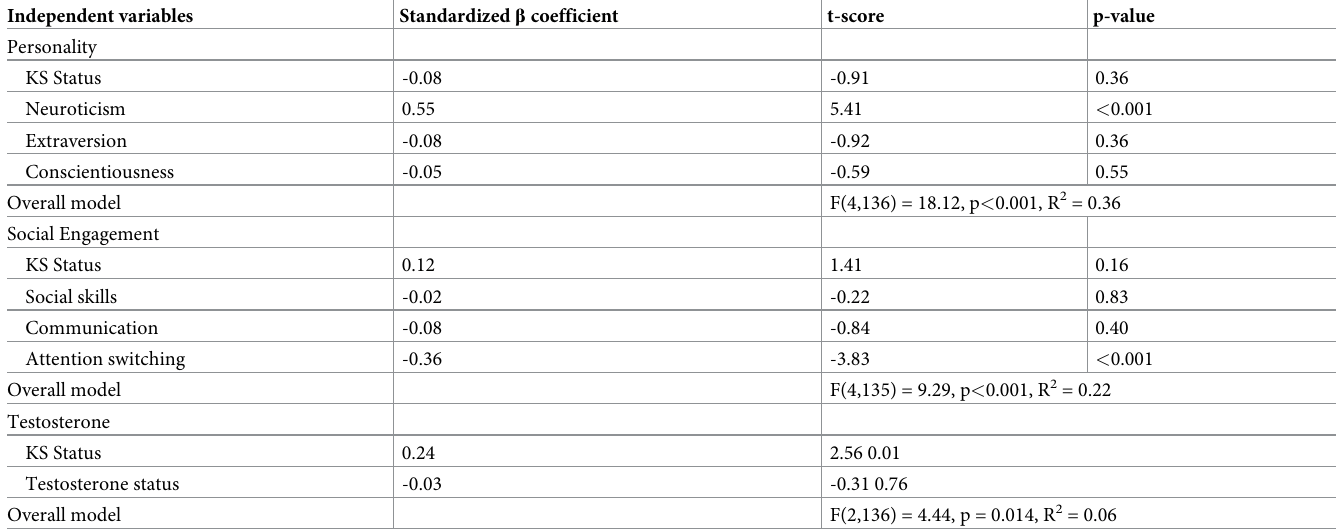
As shown in Table 4, KS status and personality measures (i.e., neuroticism, extraversion, and conscientiousness) combined to significantly predict depression symptoms (R 2 = .36, p < .001), with neuroticism emerging as the lone significant predictor (p < 0.001). Depression was also predicted by KS status and social engagement (i.e., social skills, communication, attention switching) (R 2 = .22, p < .001), with attention switching as the significant predictor (p < .001). When combining KS status and testosterone status, the overall model was significant (R 2 = .06, p = .014), but this was attributable to the impact of KS status (p = .01). Path analysis. When the significant personality and social-engagement predictors were combined with both anxiety and depression symptoms in an overall path analysis, neuroticism fully mediated the impact of KS status on both anxiety and depression (ps < .05), as seen in Table 4. Regression models predicting